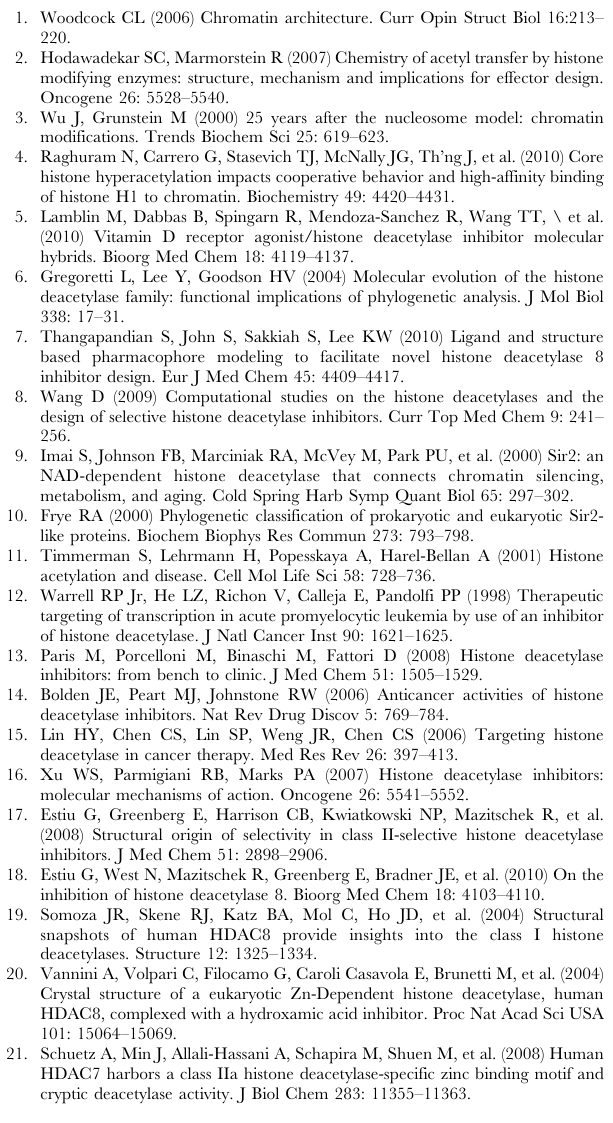
Initial and average structures of HDAC10 are shown in dark and light orange colors, respectively. (TIF) Table S1 The sets of inhibitors for HDAC8, 10 and 11 isoforms (32, 20 and 14 compounds respectively) used in molecular docking validation. The inhibitory profiles, GOLD fitness scores, and the correlation between them for individual HDAC isoforms are